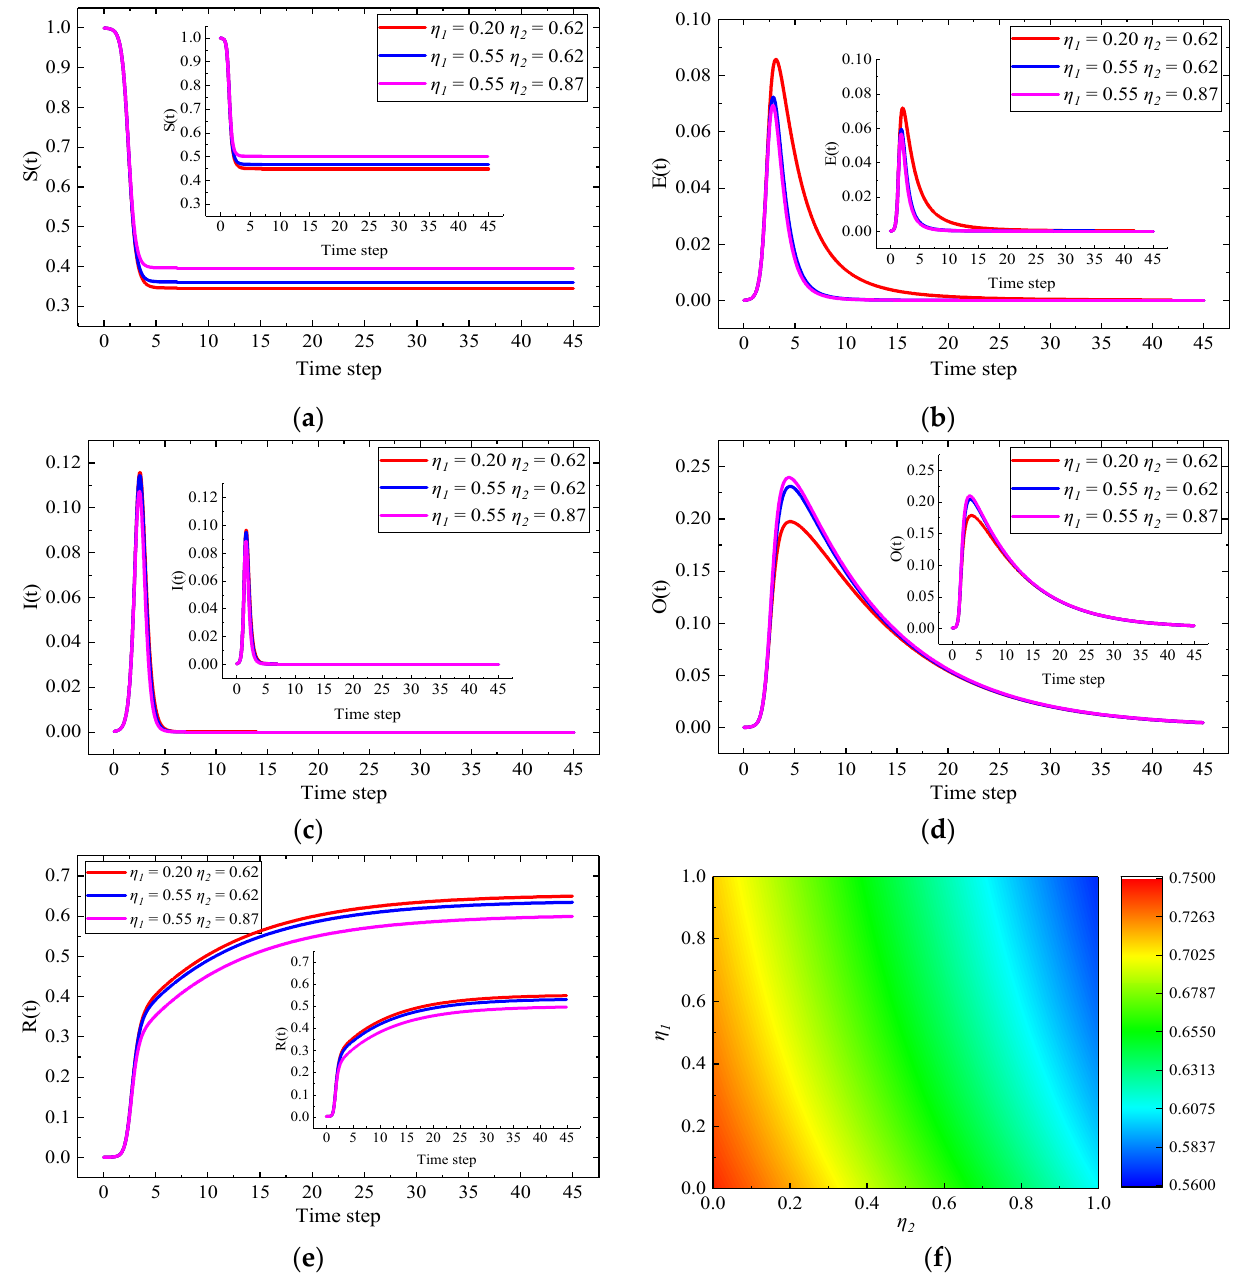
Figure 7. ( a – e ) show the density evolution curves of ignorant people, hesitators, spreaders, rumor debunkers, immunizers in the two networks under the influence of different rumor-refuting intensities (the large figure represents the simulation on the WS network and the small figure represents the simulation on the BA network); ( f ) shows the changes of immunizers in the WS network with η 1 and η 2 when the time step, t = 45. We changed the refuting rate β 2 and the reporting rate β 3 by encouraging more active and positive users to compulsorily refute rumors. The larger β 2 and β 3 are, the greater the intensity of forced refuting on spreaders. Except for β 2 and β 3 , the other parameters were set as shown in Table 2. The density evolution curves of each type of individual under different forced refuting intensities were plotted respectively, as shown in Figure